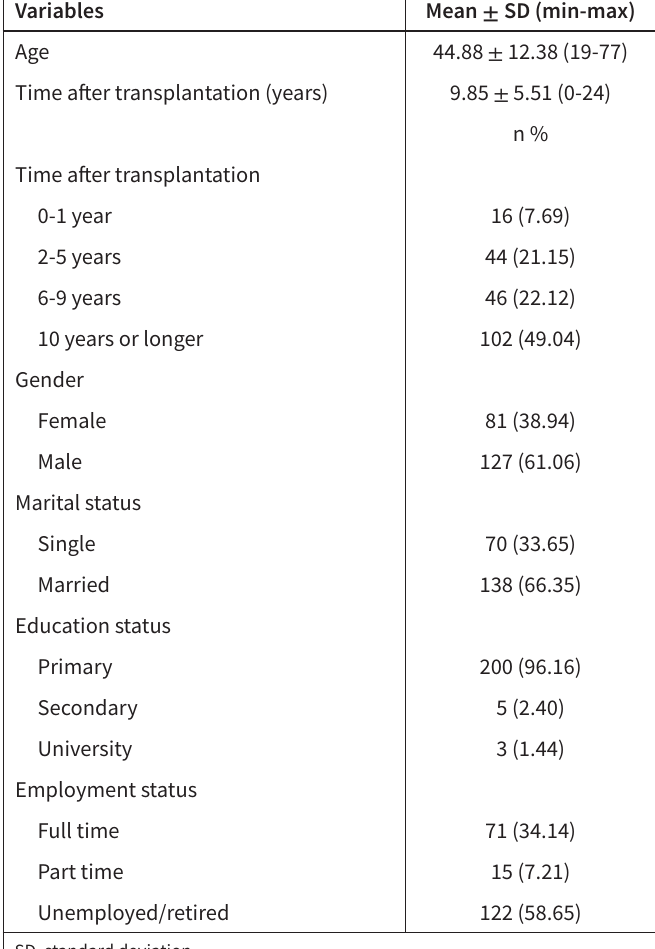
Table 1. Sociodemographic Characteristics of Kidney